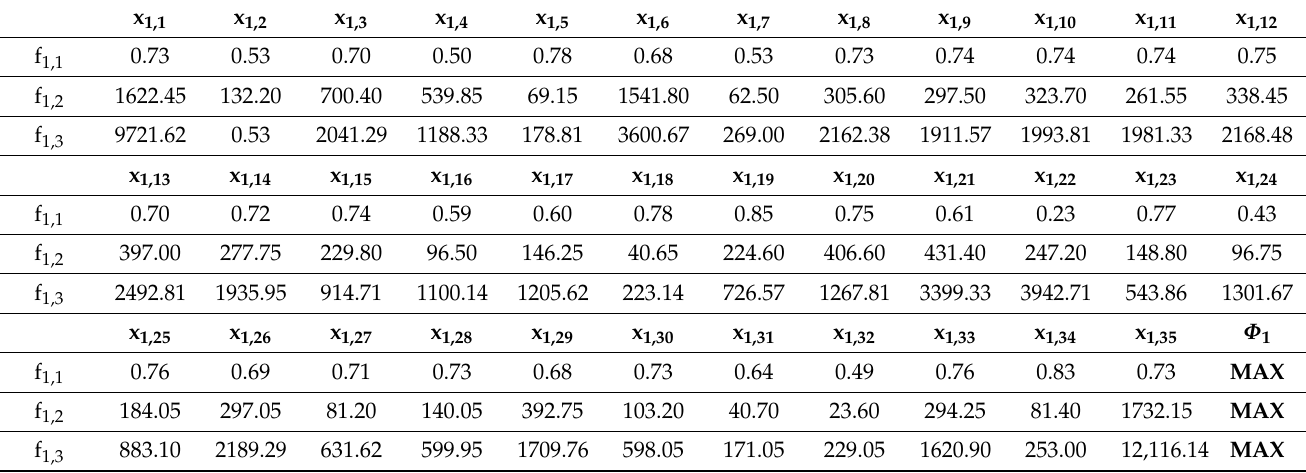
Table 1. F 1 criteria values and dominance relationship Φ 1